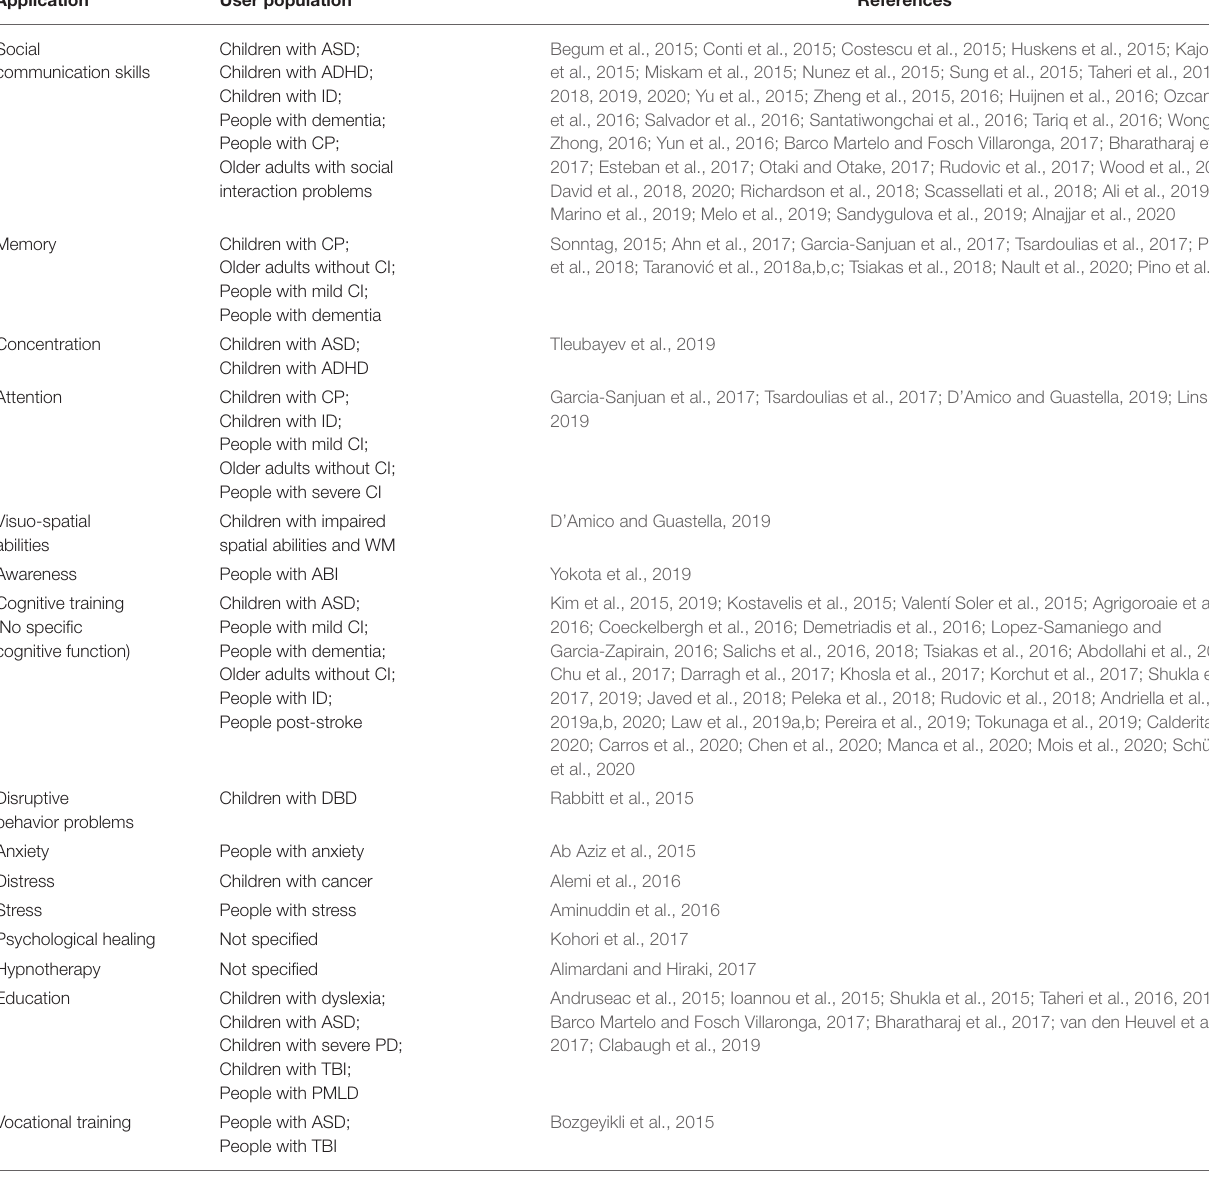
TABLE 1 | Type of robot-assisted cognitive training and end-user